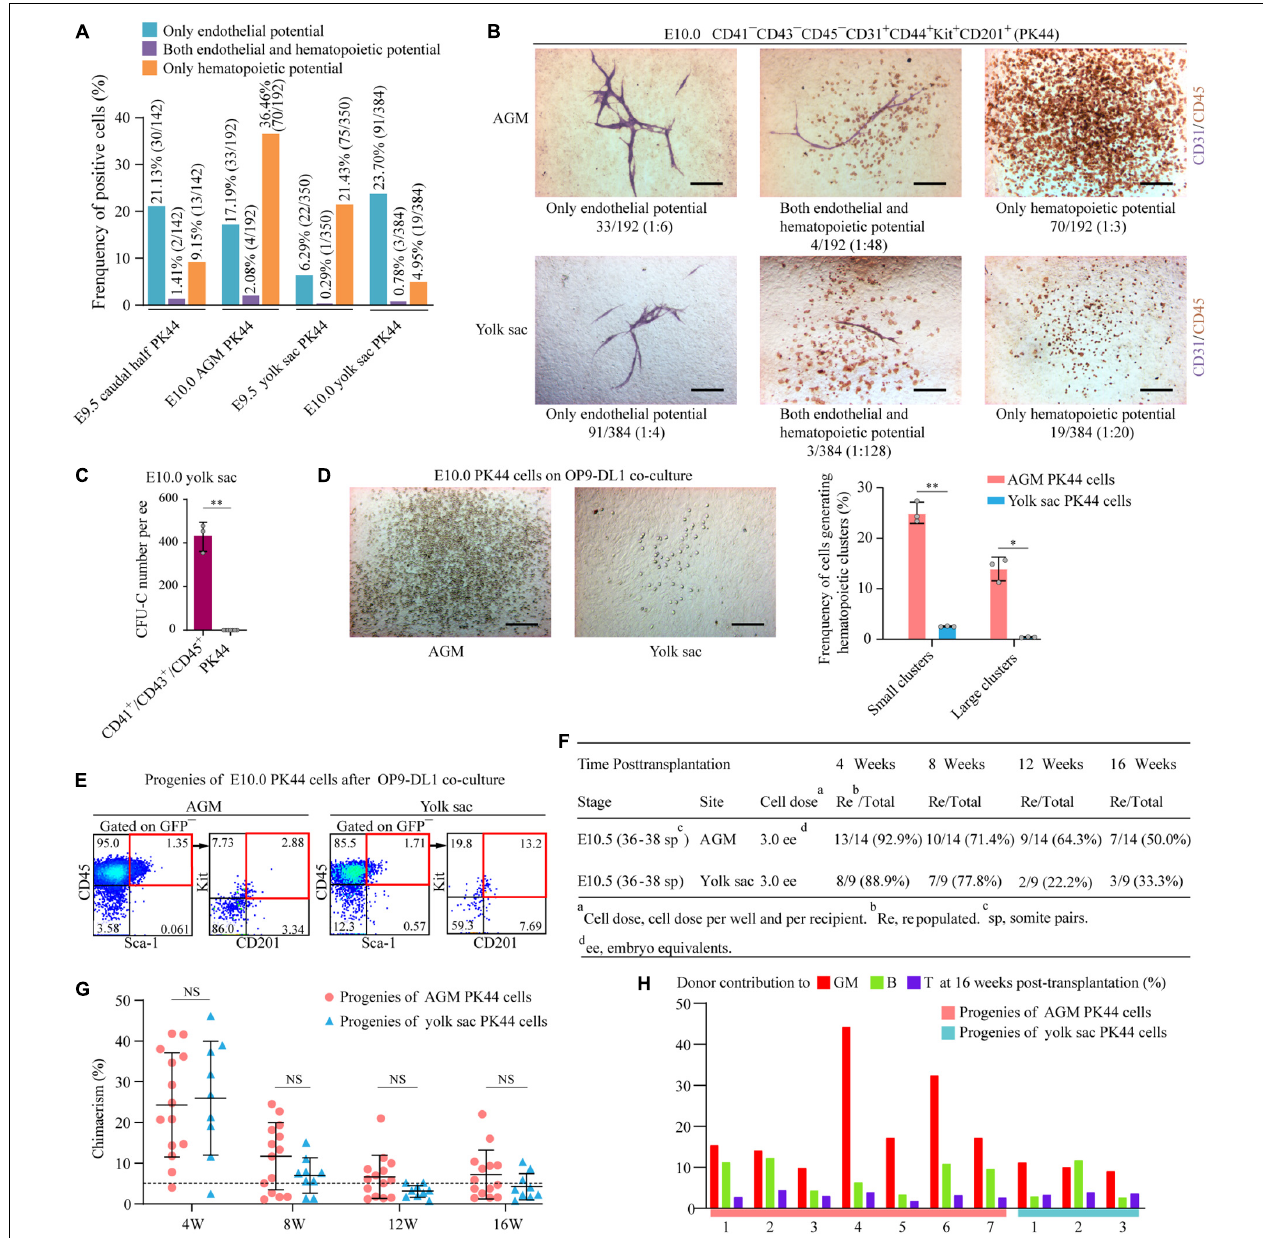
FIGURE 4 | Functional evaluation of yolk sac PK44 cells. (A) Column charts showing the frequencies of potential-positive cells in the indicated populations for each kind of differentiation potentials. Data are from three independent experiments. (B) Representative CD31 and CD45 immunostaining on the cultures of single PK44 cells from E10.0 AGM and yolk sac, showing typical morphologies regarding distinct differentiation potentials. Cell frequencies of each kind of potentials are shown. Data are from three independent experiments. Scale bars, 100 µ m. (C) Number of hematopoietic progenitors per embryo equivalent (ee) in the indicated populations derived from E10.5 yolk sac measured by the methylcellulose CFU-C assay. Data are means ± SD. The statistical significance of differences was determined using the Wilcox test. ∗∗ P < 0.01. Data are from three independent experiments. (D) Morphology of hematopoietic progenies generated by AGM (left) and yolk sac (middle) PK44 cells after OP9-DL1 co-culture for 5 days. Scale bars, 100 µ m. Column charts in the right showing the frequencies of AGM and yolk sac PK44 cells generating small or large hematopoietic clusters. Data are from three independent experiments. Data are means ± SD. The statistical significance of differences was determined using Pearson’s chi-squared test. ∗ P < 0.05; ∗∗ P < 0.01. (E) Representative FACS plots of analyzing the progenies of E10.0 AGM and yolk sac PK44 cells following 7 days co-culture, showing a population of cells expressing putative HSC markers. (F) Detailed information of the transplantation assays performed with the progenies of E10.5 AGM and yolk sac PK44 cells. (G) Graphs showing the donor chimerism from 4 to 16 weeks after being transplanted with the progenies of the E10.5 AGM and yolk sac PK44 populations (three embryo equivalents per recipient), respectively. Data are means ± SD. The statistical significance of differences was determined using Mann–Whitney test. NS, not significant. (H) Bar plots showing the donor contribution to the granulocytes/monocytes (GM, red), B lymphocytes (green), and T lymphocytes (purple) in the peripheral blood of each of the primary recipients receiving the progenies of E10.5 AGM and yolk sac PK44 cells at 16 weeks